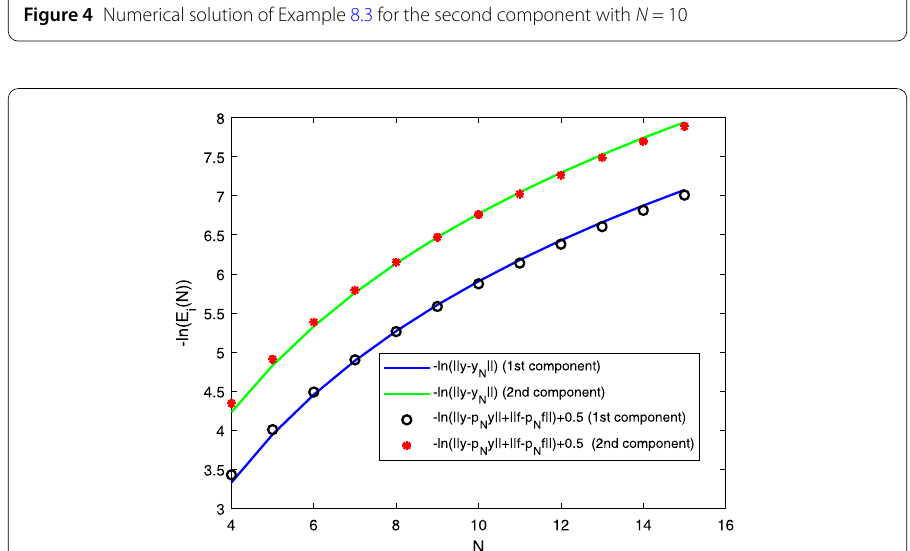
Figure 5 The natural logarithm of the e 0.5 ( (cid:12) y – p N y (cid:12) ∞ + (cid:12) f – p N f (cid:12) ∞ ) and (cid:12) y – y N (cid:12) ∞ versus N , in Example